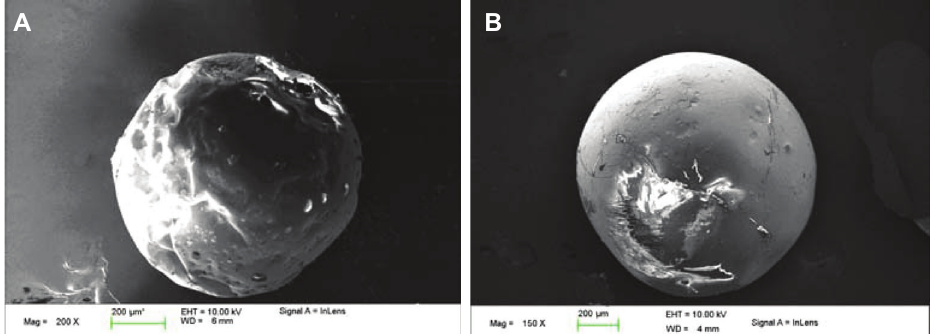
Figure 1 (A) Surface morphology of spheres obtained in PVA and (B) PVA and SDS aqueous solution.